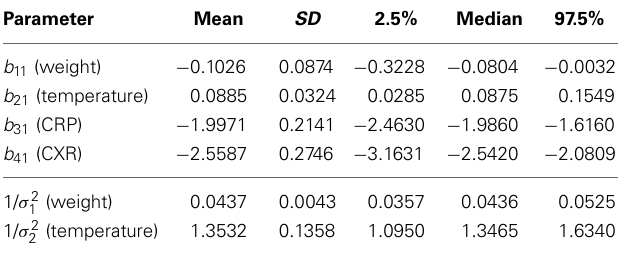
Table 1 | Distributions of parameter estimates.